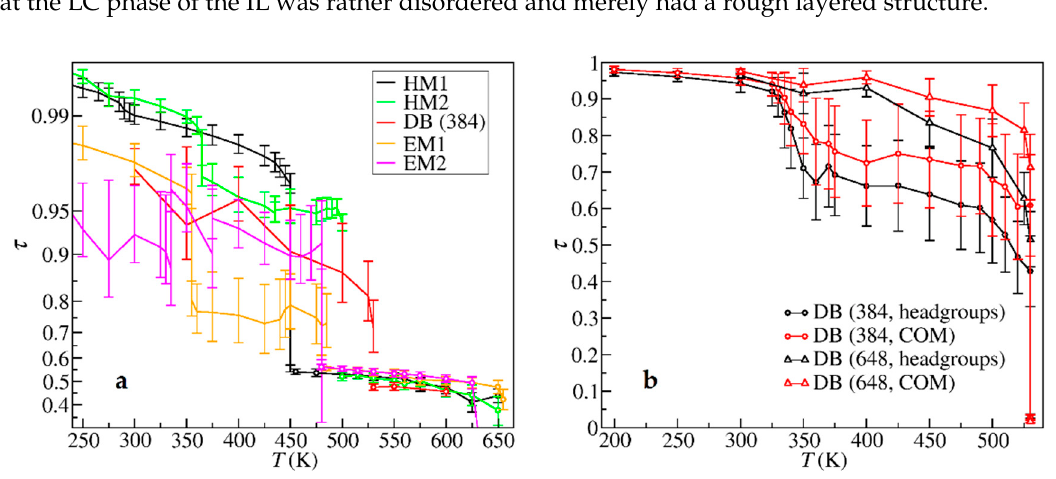
Figure 6. ( a ) Translational order parameters (TOPs) of the crystal and SmA liquid crystal structures; ( b ) Crystalline TOPs of the DB structure calculated for the center of masses (COMs) of headgroups, anions, and cations with 384 and 648 ion pairs, respectively.